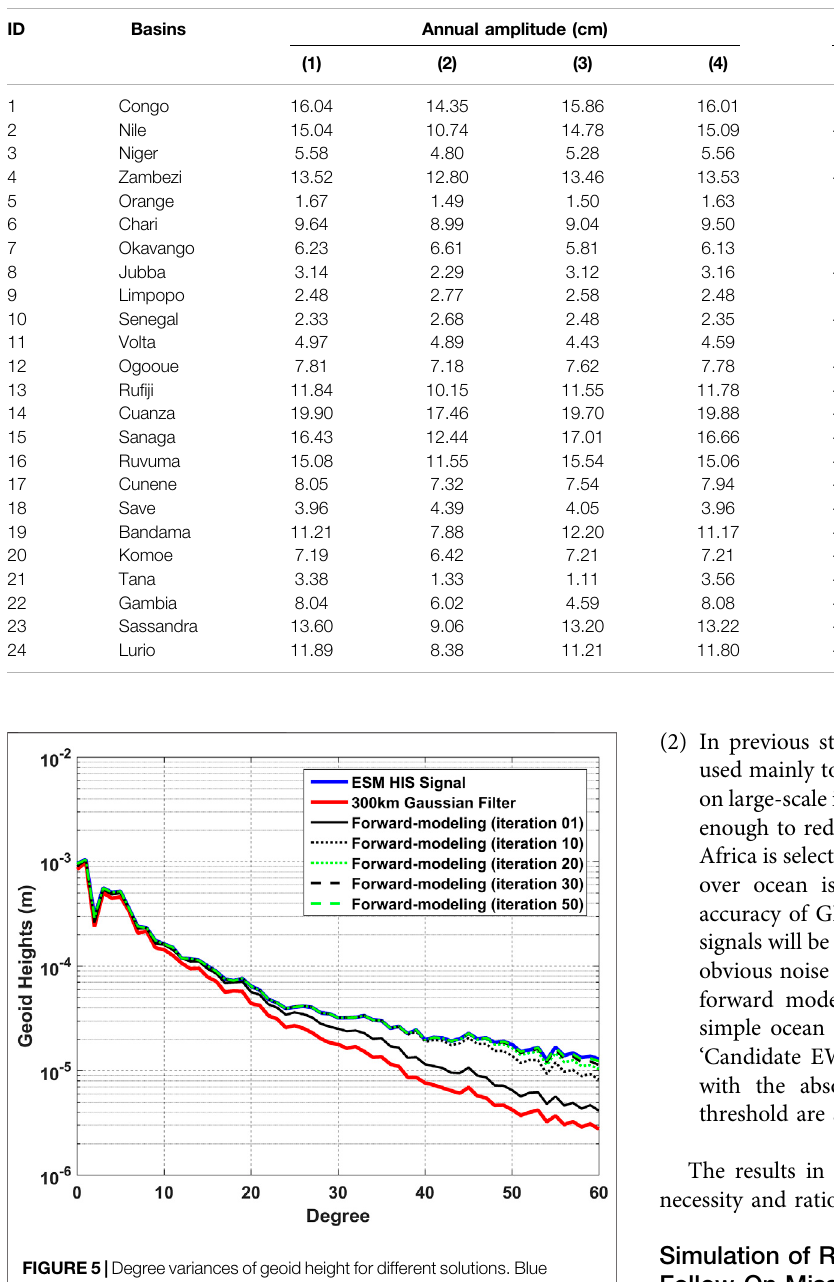
Frontiers in Earth Science |